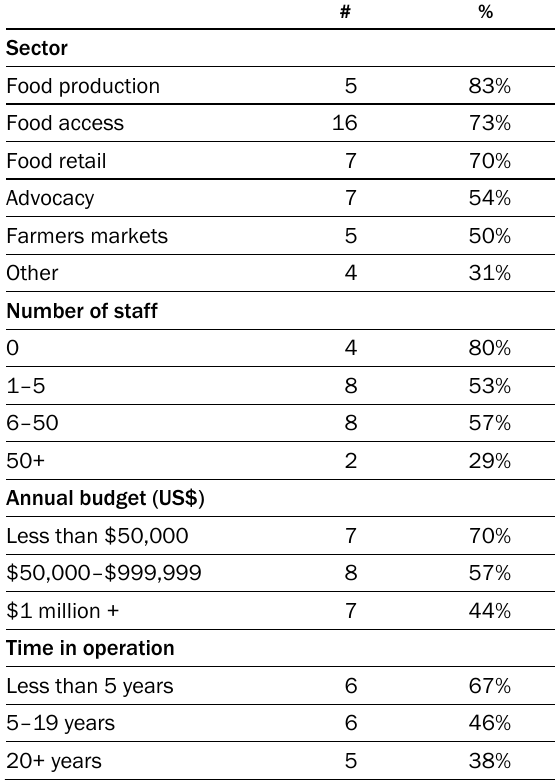
Table 7. Survey Respondents Employing New Distribution Methods During the